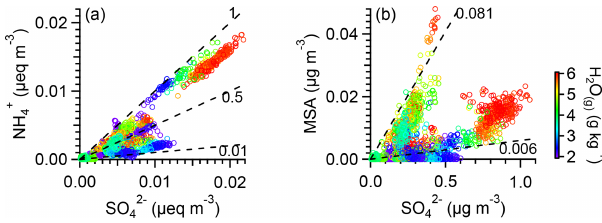
Figure 4. Scatter plots that compare (a) ammonium molar equiva- ] / 18) vs. sulfate molar equivalent concen- lent concentration ( [ NH + 4 ] / 48) and (b) MSA mass concentration vs. sulfate tration ( [ SO 2 − 4 mass concentration. Data points are colored by water vapor mixing ratio. Dashed lines with different slopes are added for reference.